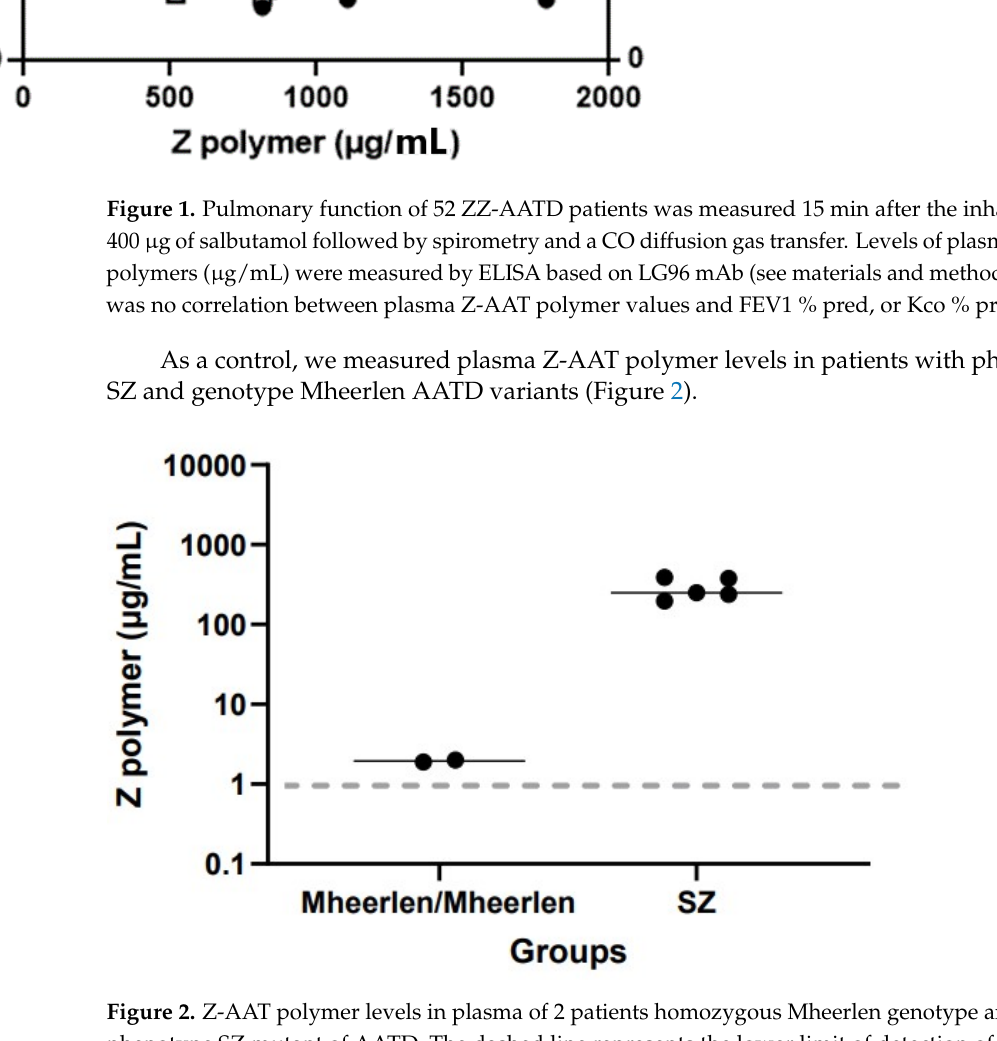
Figure 3. Repeatedly determined plasma levels of Z-AAT polymers in two randomly selected ZZ- AATD patients. On 14 consecutive days, plasma levels of Z-AAT polymers remained relatively sta- ble in both patients. Based on the fact that Z-AAT polymers are heterogenous and that different antibod- ies can recognize different profiles of polymers, we analyzed plasma samples from ran- domly selected ZZ AATD patients using 7.5% native PAGE following western blotting using anti-Z-polymer antibodies LG96 or 2C1 (Figure 4). Both antibodies are suitable for